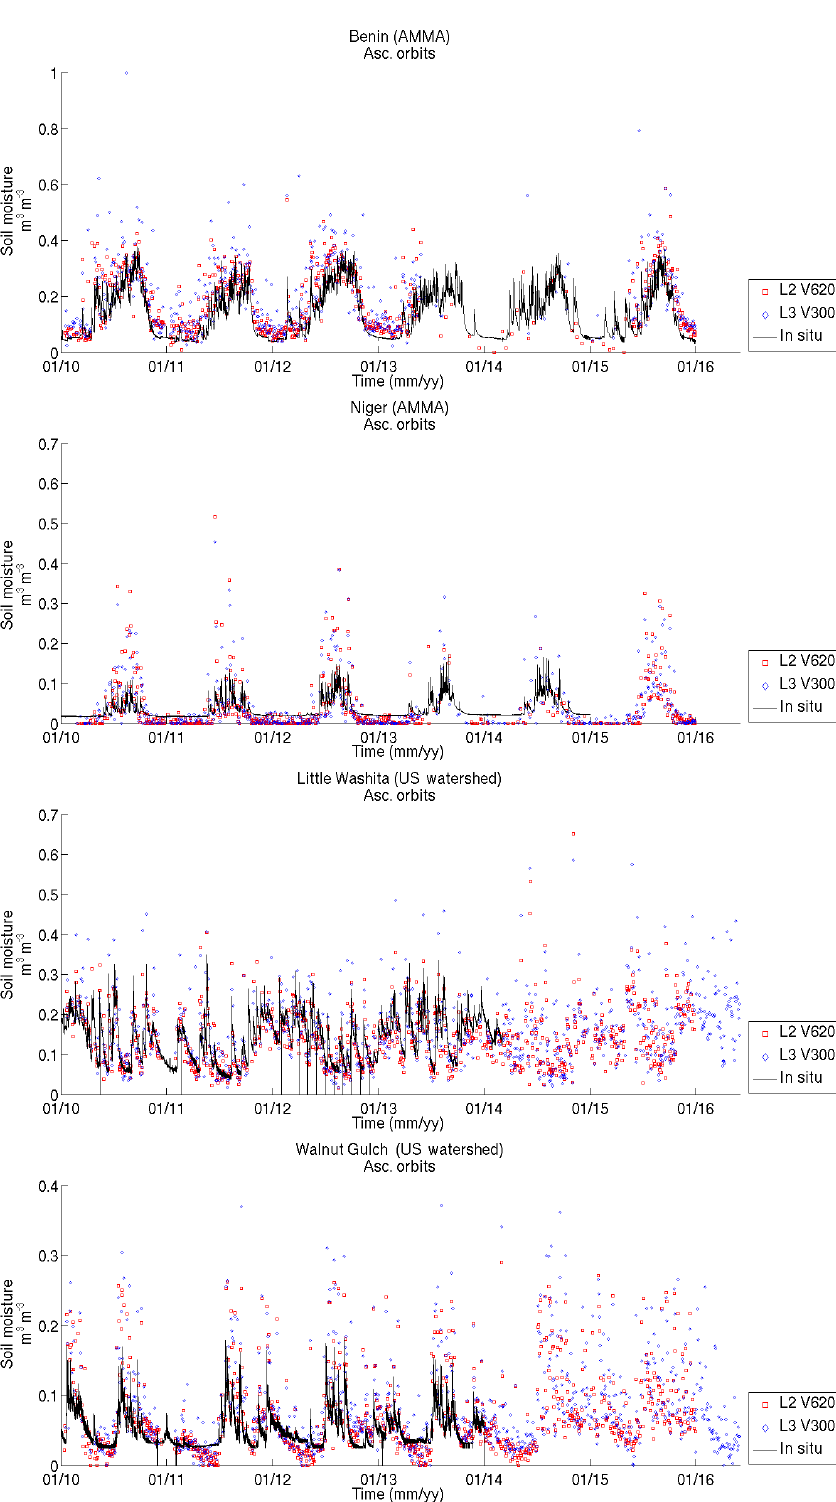
Earth Syst. Sci. Data, 9, 293–315, 2017